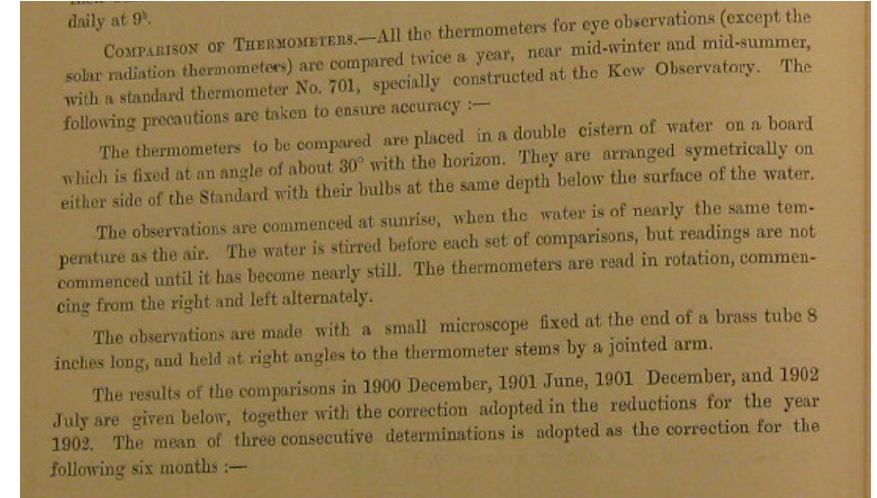
Figure 7. Description of the biannual comparison of thermometers in the 1902 blue book imaged by NOAA NCEI, which is then accom- panied by a further page of tabulated results pointing to good apparent stability of the instruments and further commentary on ensuring long-term stability of the standard via vicarious calibration against newly shipped thermometers that have been calibrated prior to shipment against the primary standard held at